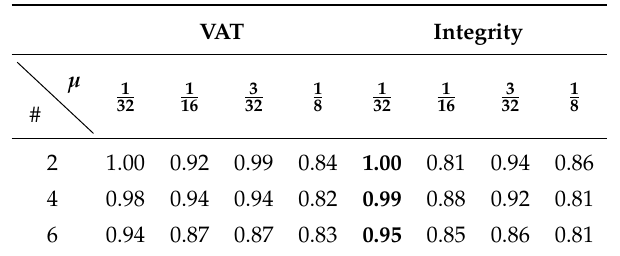
Table 9. Normalized mutual information for Girvan–Newman Graphs with overlap. Bold text indicates one-step